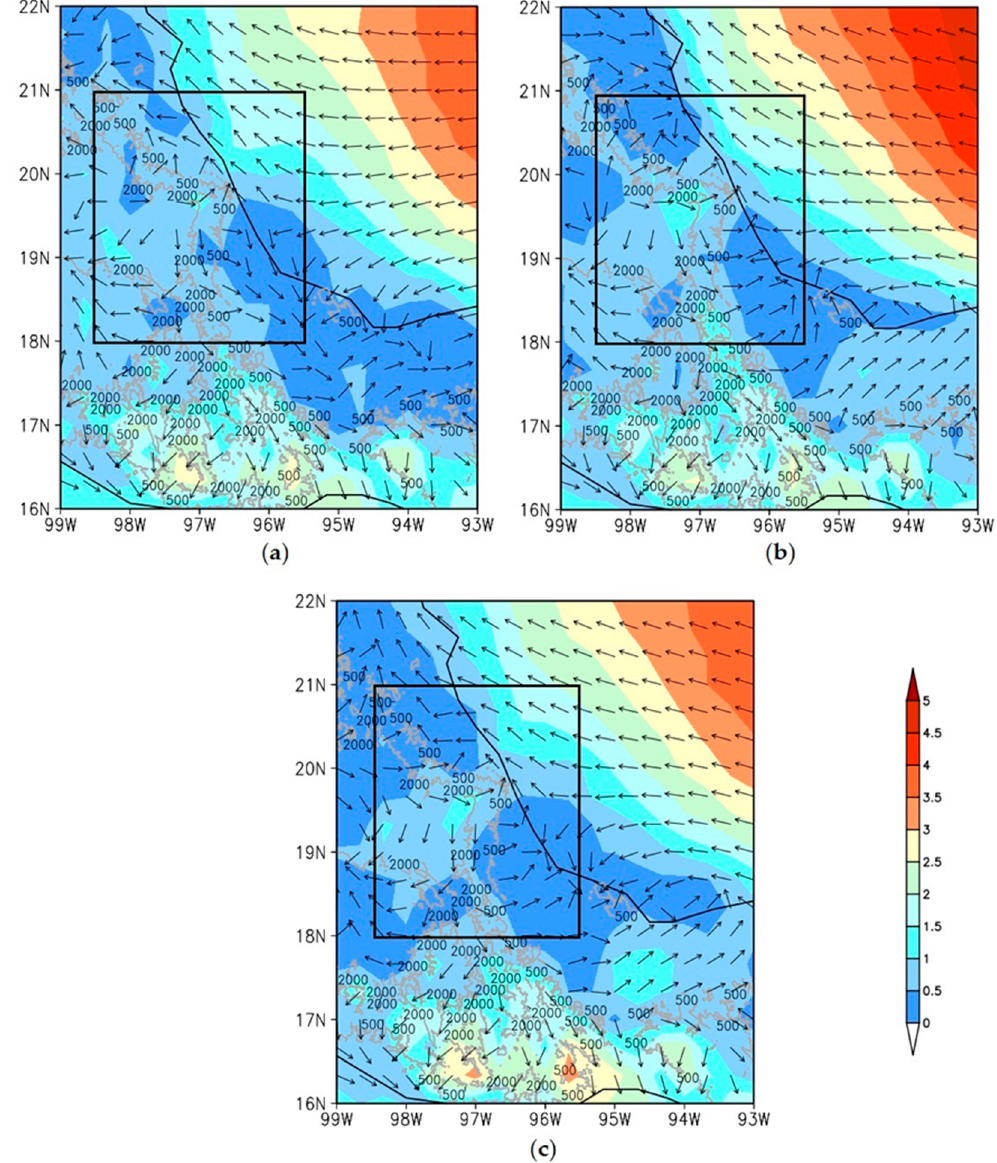
Figure 8. Average wind field (m s − 1 ) at 10m during the summer (May–October) for the ( a ) 04 LT, ( b ) 07 LT, and ( c ) 10 LT, from NARR reanalysis data for the period of 1979–2012. For clarity, the vectors correspond only to the wind direction; the magnitude is indicated by shaded. The contours of 500 and 2000 m.a.s.l. are shown.